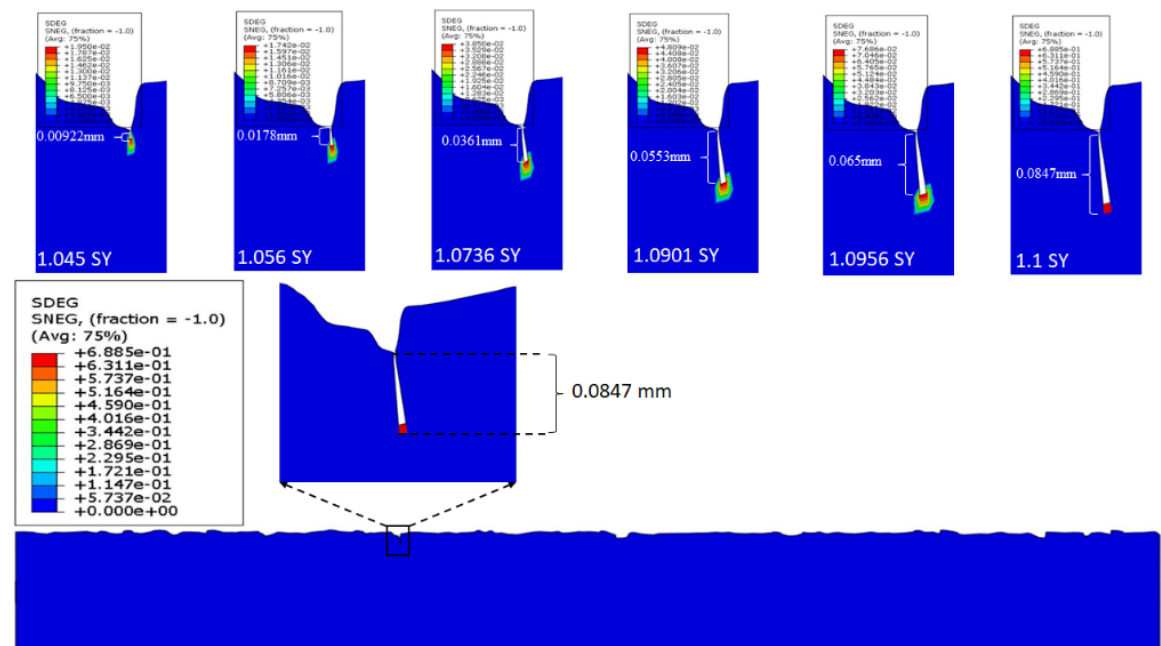
time for residual stress before being relaxed.